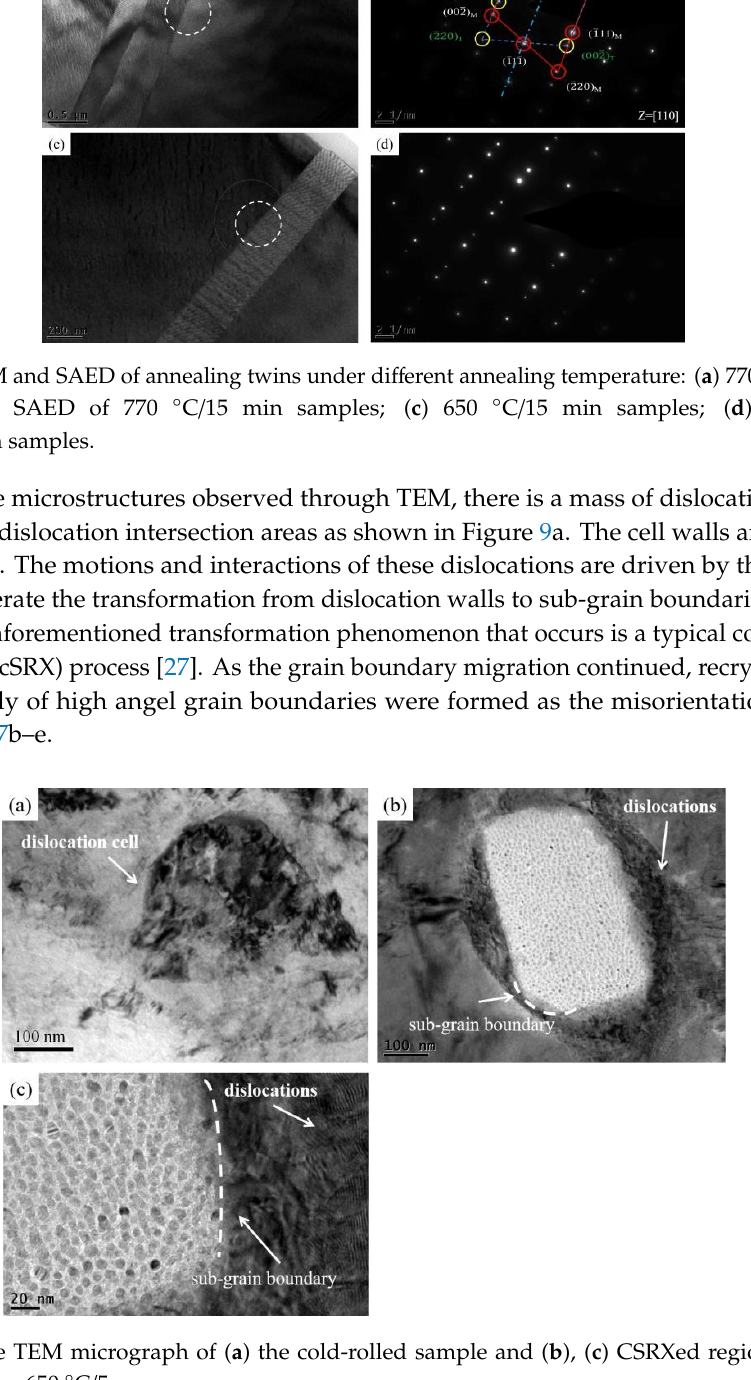
Figure 7. Misorientation of cold-rolled and annealed Cu-2.7Be samples: ( a ) cold rolled; ( b ) 650 °C/15